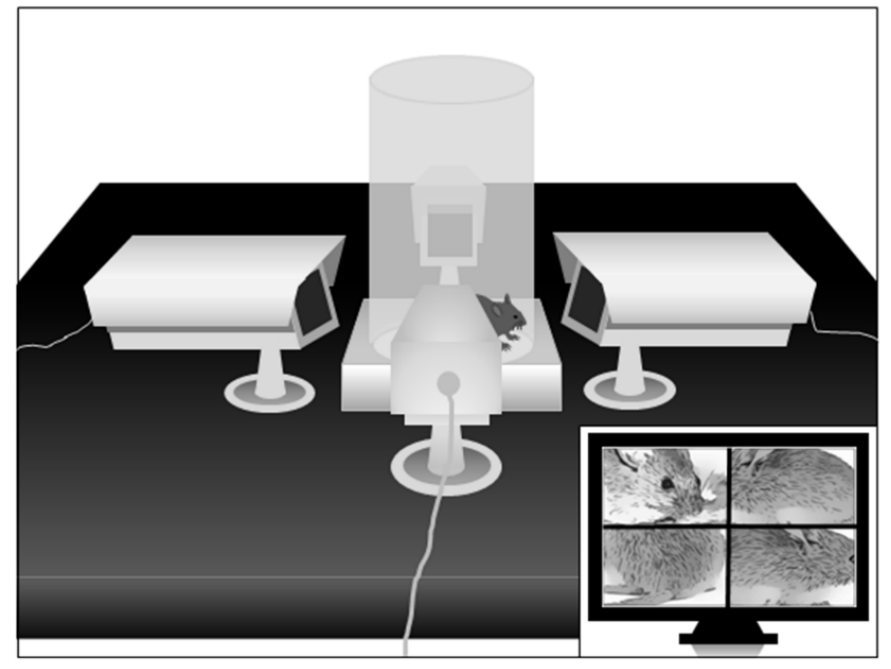
Figure 2. Schematic representation of the apparatus to study spontaneous eyeblinks in mice. For fur- ther details, see